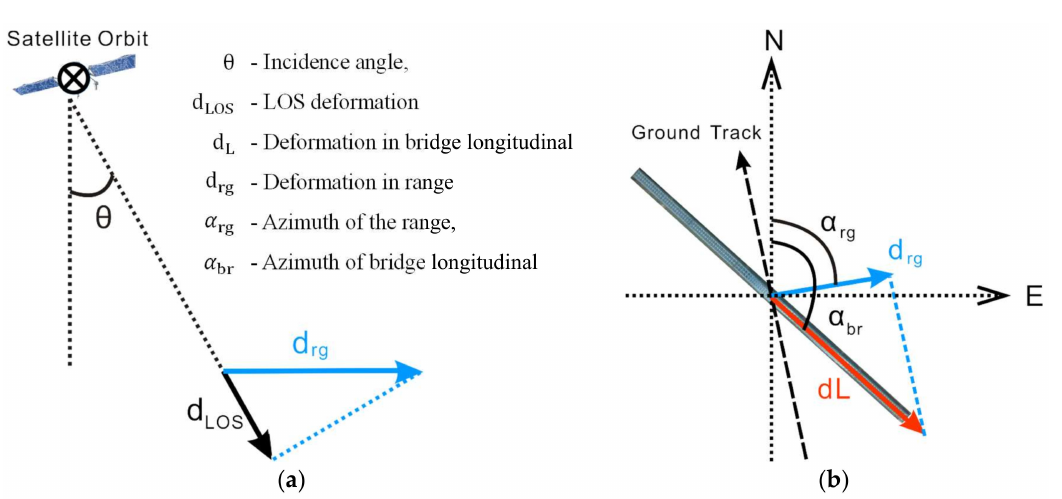
Figure 4. Relation between the line of sight (LOS) displacements and those in the bridge longitudinal direction. Scheme in the vertical plane ( a ) and in the horizontal one ( b ). It is worth noting that in this analysis it has been assumed that the bridge slope is almost zero.